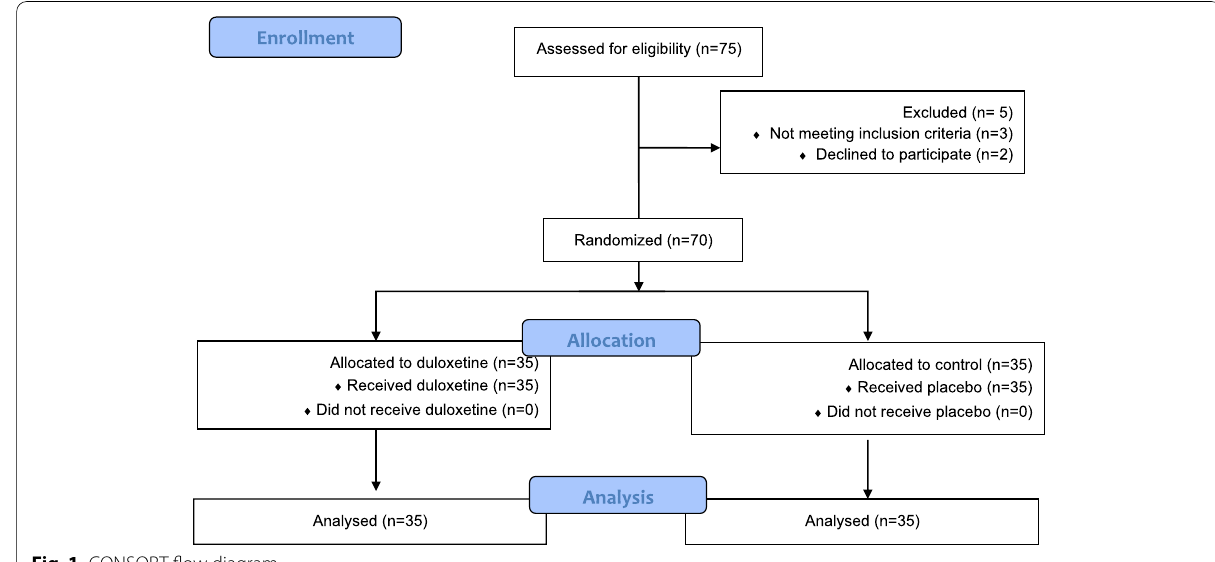
Fig. 1 CONSORT flow diagram